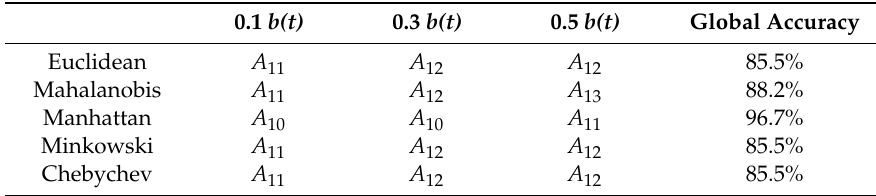
Table 7. E ff ect of distances, with MinPts = n /2, 17 features, ε = 0.094.